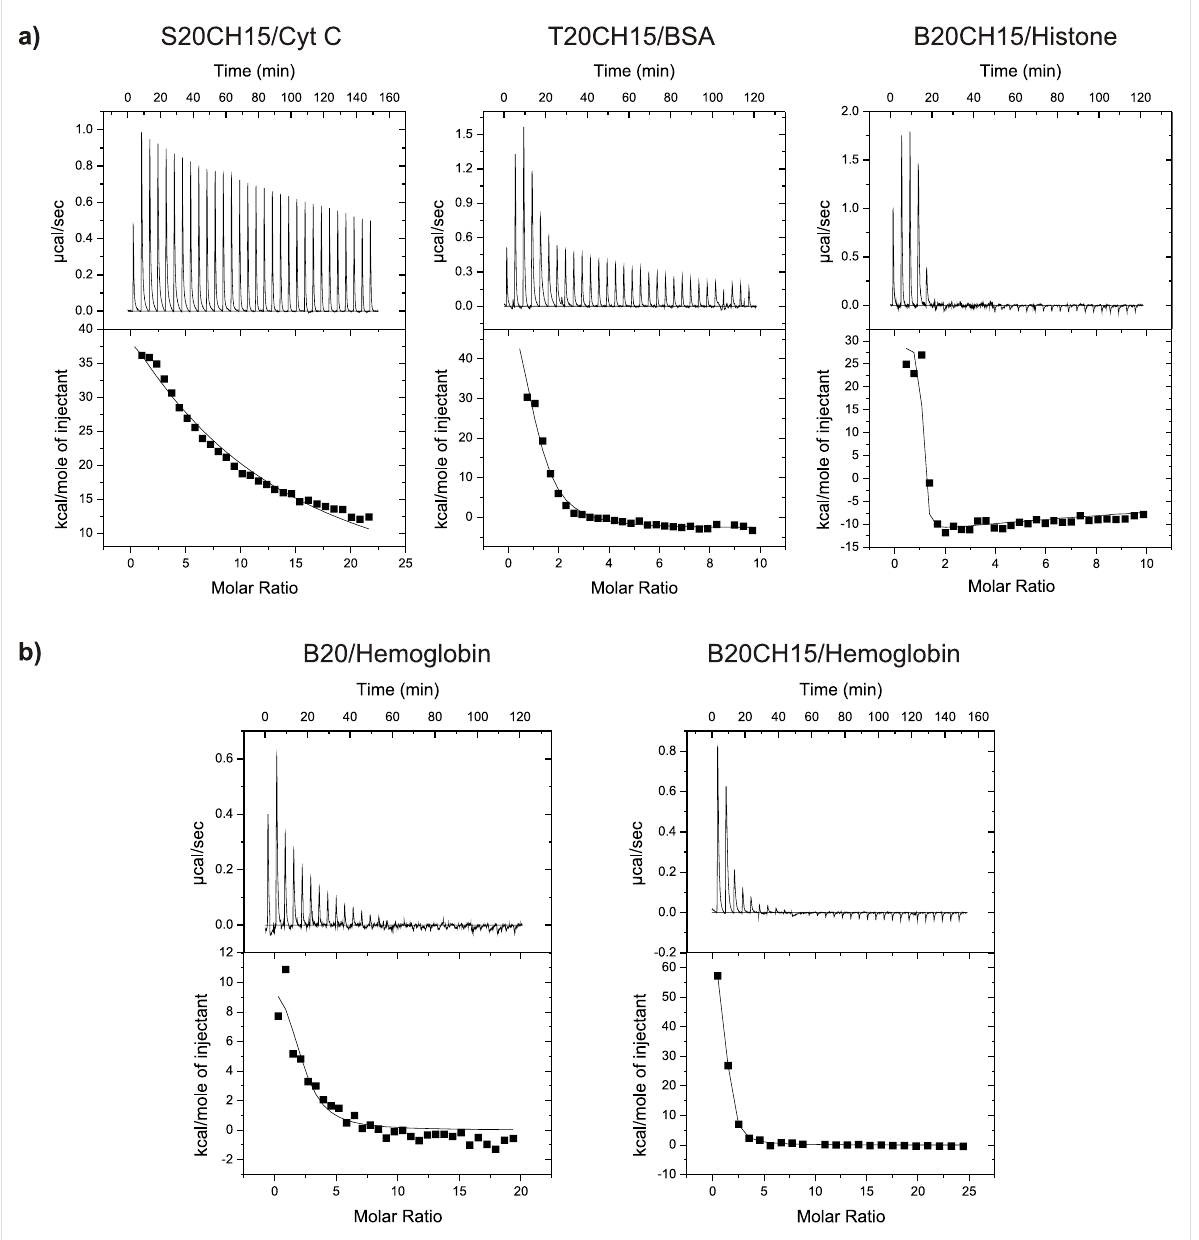
Figure 3: Isothermal calorimetric binding curves for selected polymer/protein host–guest pairs. a) Typical binding curves with representative proteins for the major polymers based on the three anionic binding sites. Note the marked affinity increase from sodium methacrylate over tetrazolate to bisphosphonate dianion. b) Binding curves of two bisphosphonate RAFT copolymers, one without and one with the hydrophobic N -cyclohexylacryl- amide comonomer (15 mol %). The contribution of the nonpolar cyclohexyl monomer towards hemoglobin binding is evident from the steeper slope of the binding